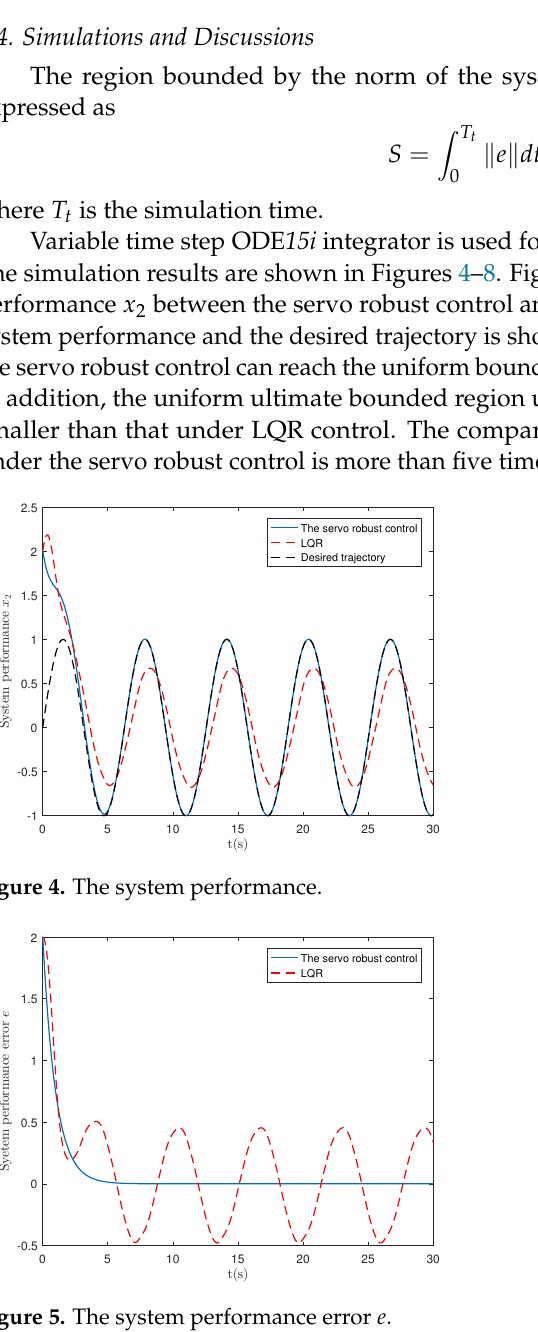
Figure 5. The system performance error e